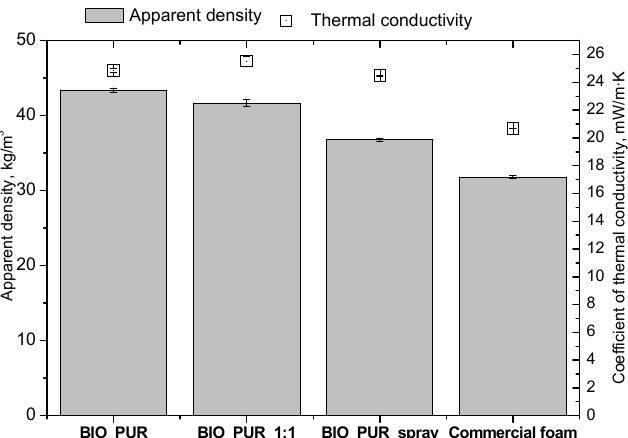
Figure 3. The apparent density and thermal conductivity of spray PUR bio-foams obtained on laboratory and industrial scales.